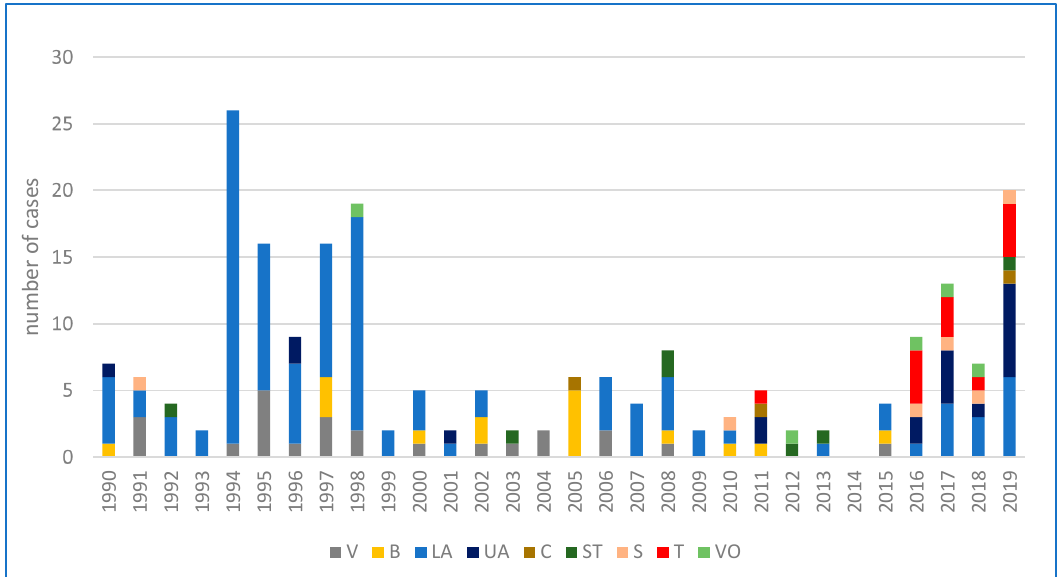
Figure 1. Cumulative cases of human tularemia in Austria divided by provinces from 1990–2019. Abbreviations: V = Vienna, B = Burgenland, LA = Lower Austria, UA = Upper Austria, C = Carinthia, ST = Styria, S = Salzburg, T = Tyrol, VO = Vorarlberg [82].